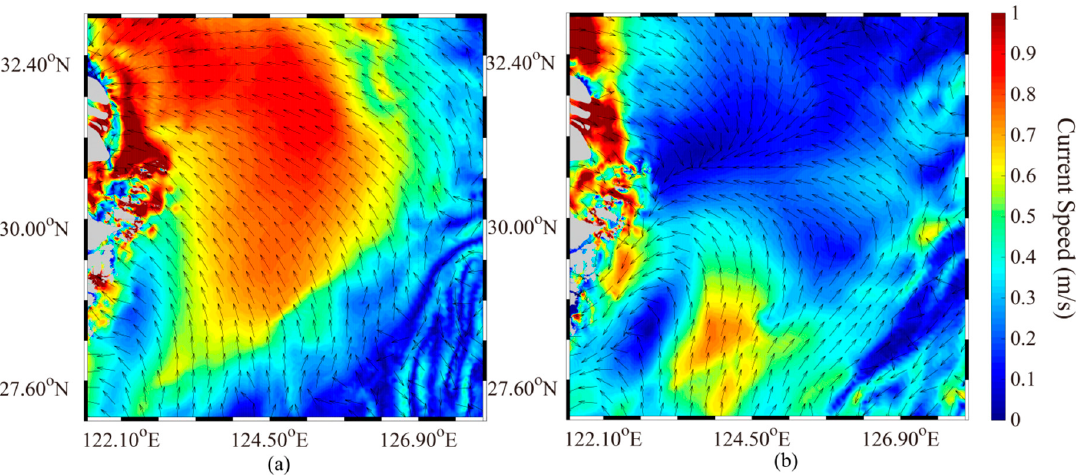
Figure 6. Current-speed maps from the FVCOM simulation at (a) 13:00 UTC on 22 September 2014 and (b) 06:00 UTC on 11 July 2015.